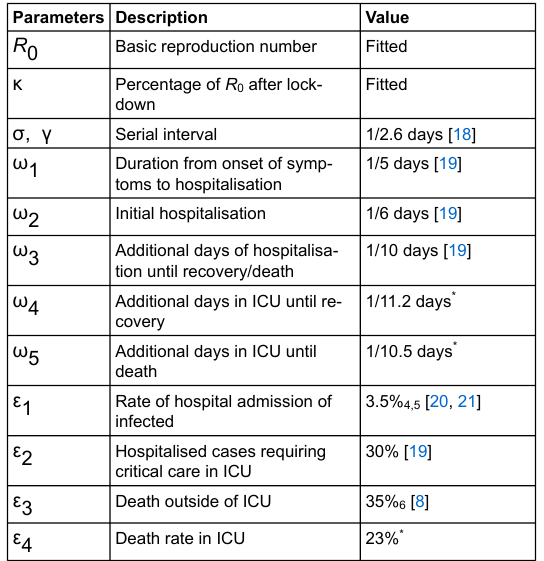
Table 1: Parameters, descriptions and values in CZ model.